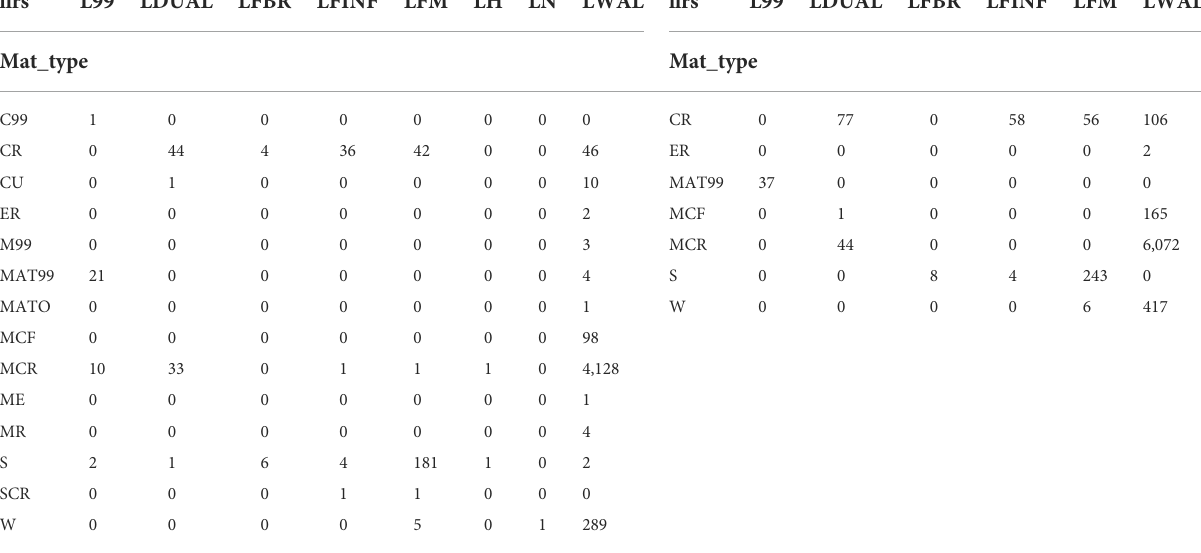
TABLE 1 Cross-tabs from Material type and